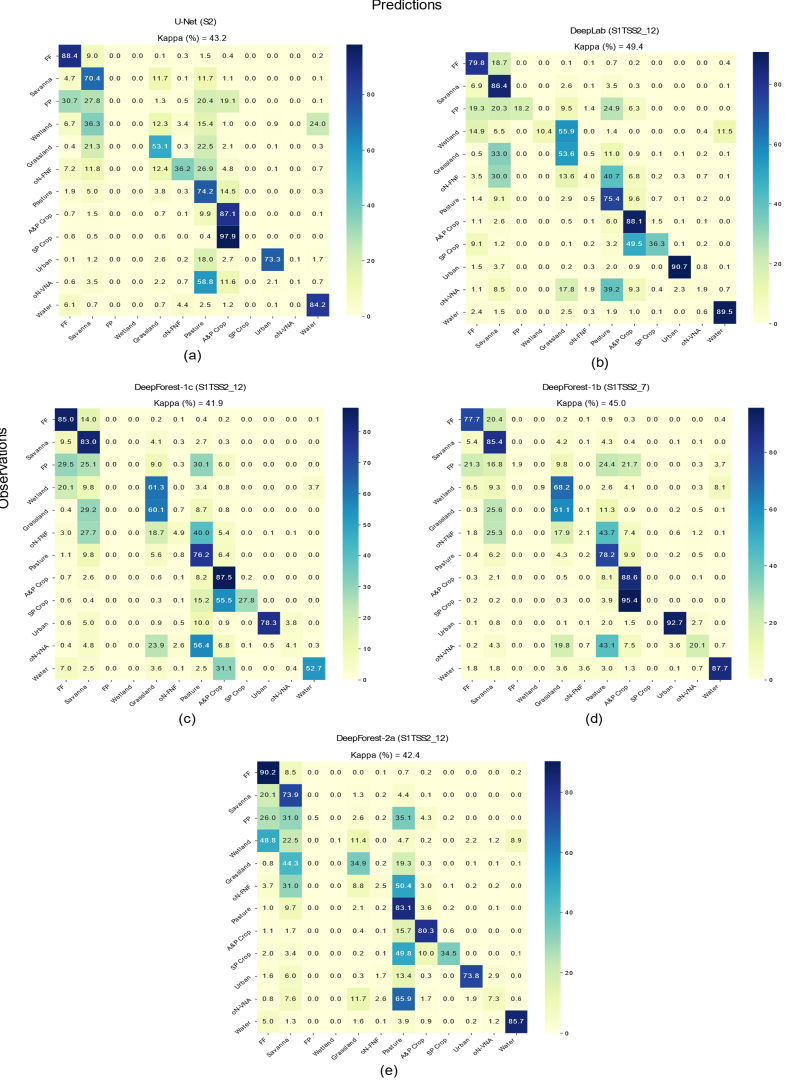
Figure A1. Confusion matrices and the associated kappa metric for each model with their respective best-performing datasets in brackets: ( a ) U-Net ( b ) DeepLab ( c ) DeepForest-1c ( d ) DeepForest-1b ( e ) DeepForest ‐ 2a.